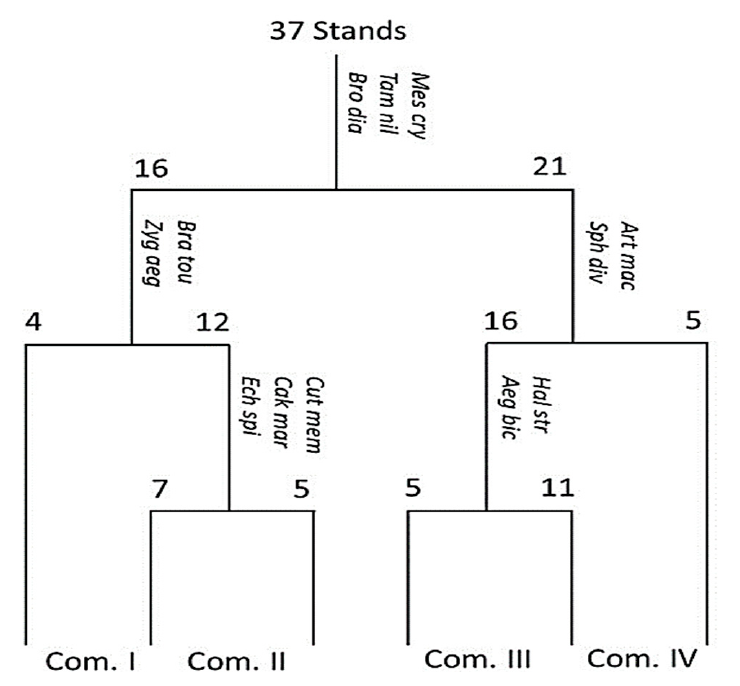
Figure 2. TWINSPAN dendrogram of 37 stands based on the important value of plant species. The first three letters of both the genus and species names are an abbreviation of the indicator species